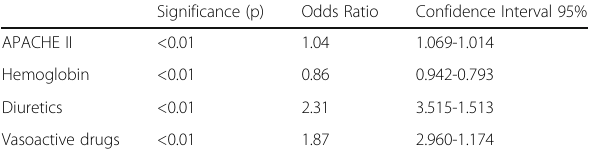
Fig. 125 (abstract A323). ROC Curve ''Angina Renal Index Score''